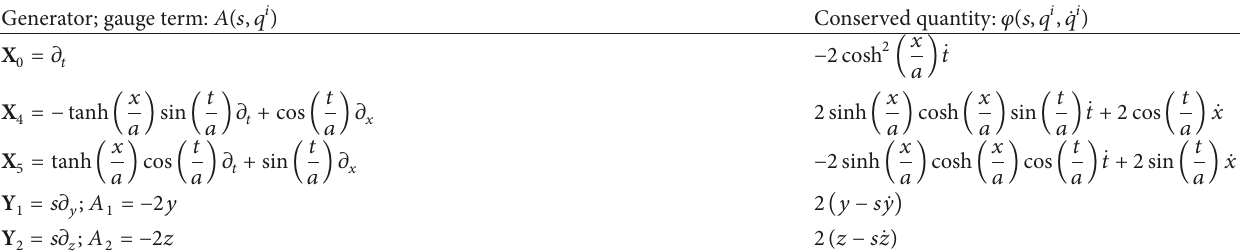
Table 10: Conserved quantities corresponding to each Noether symmetry.